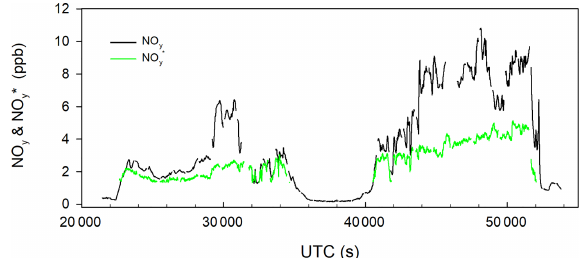
Figure 3. PGS flight 12 on 31 January 2016. NO y (observed) and NO ∗ y